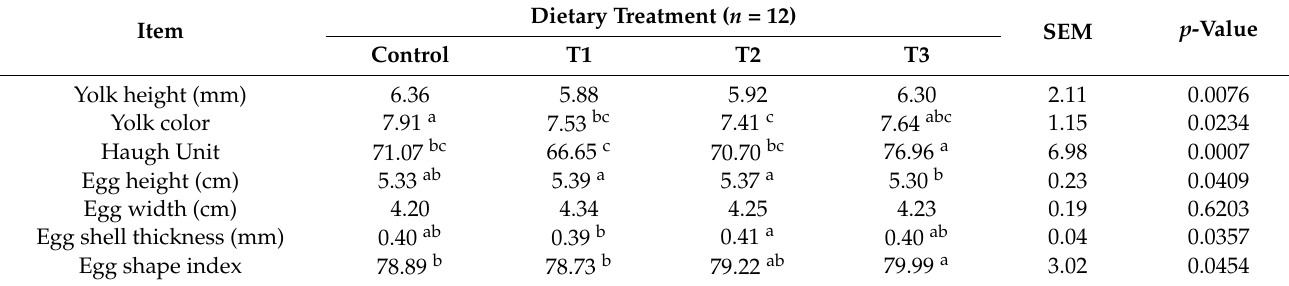
Table 3. Effects of Mentha arvensis (MA) and Geranium thunbergii (GT) on the egg quality